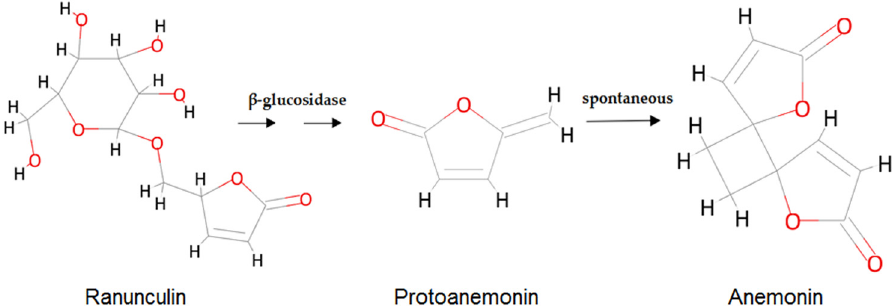
Figure 1: Transforming ranunculin into protoanemonin and